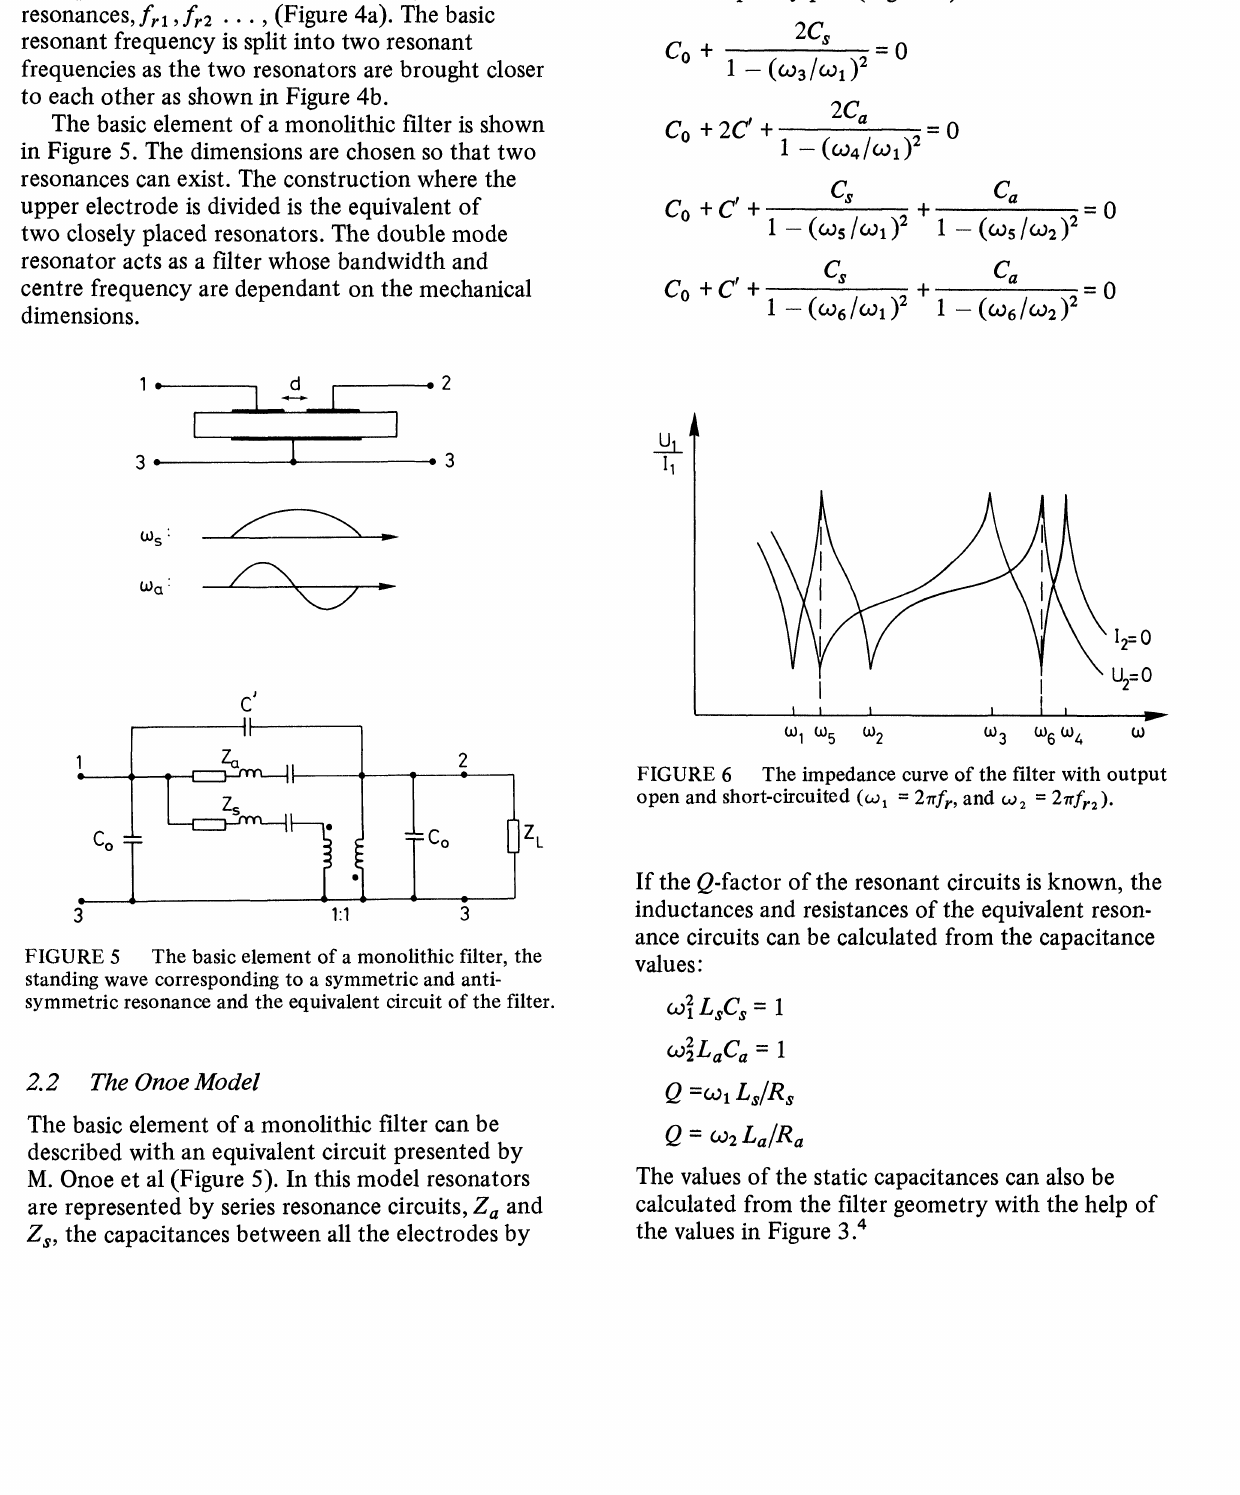
The basic element of a monolithic filter, the standing wave corresponding to a symmetric and anti- symmetric resonance and the equivalent circuit of the filter.